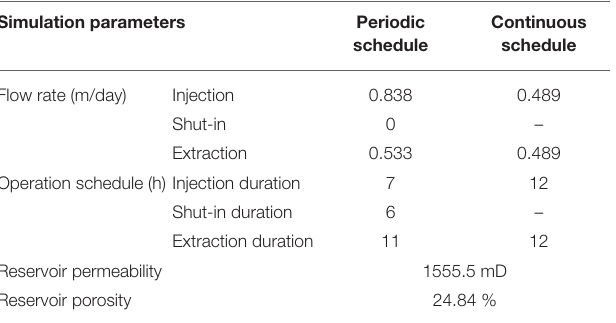
TABLE 2 | Simulation Parameters for the periodic and continuous simulation